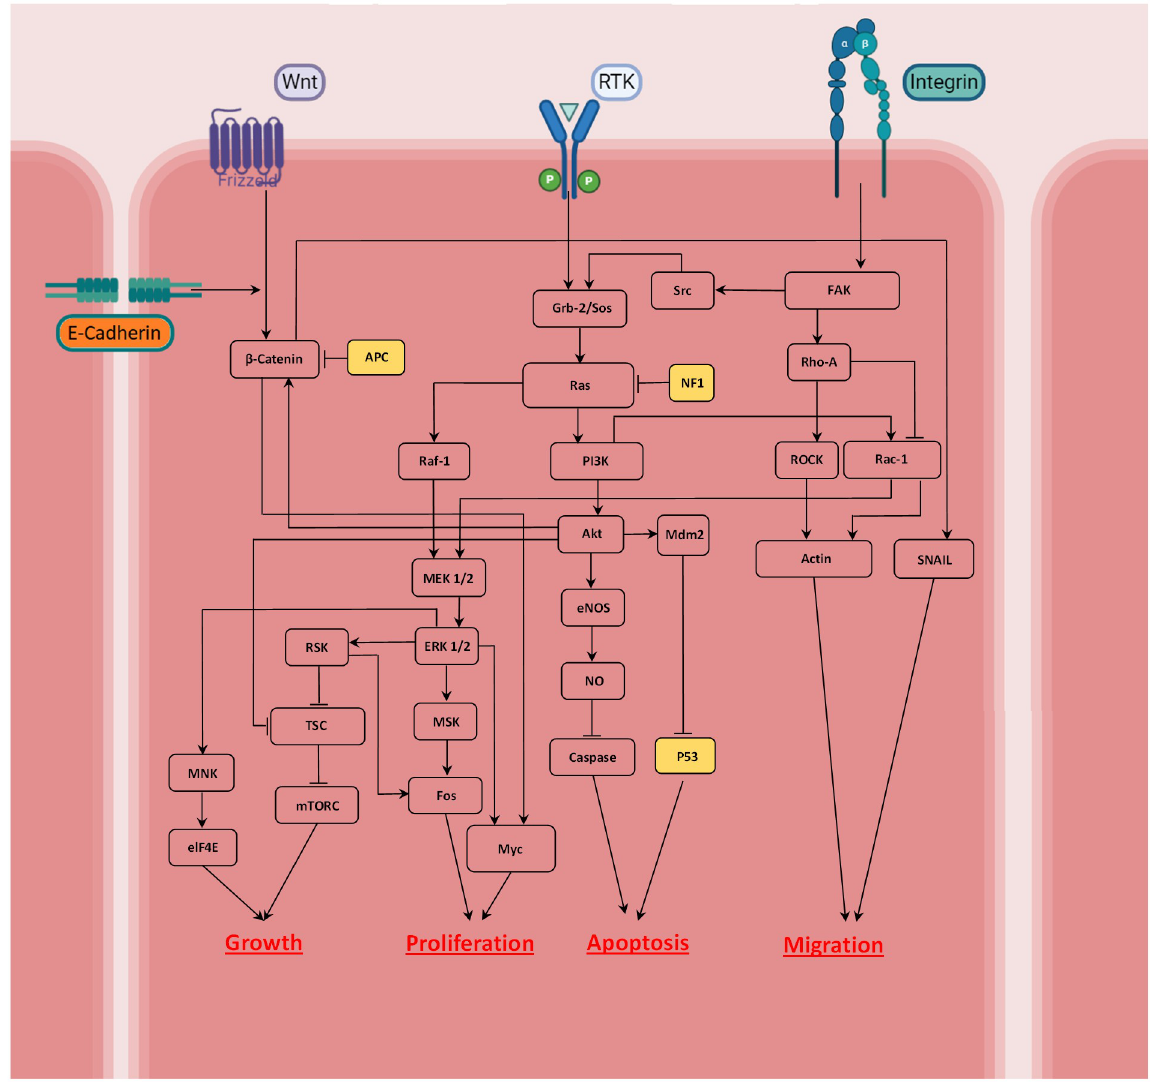
Fig 2. Signaling networks considered in the model that are involved in tumor growth; the implemented network focuses on Ras- PI3K-Akt and Wnt/ß-catenin signaling that control the cancer cell state. Highlighting the relationship between external stimuli, Wnt, RTK, cadherin and integrin, the cell can be growing, proliferating, migrating or undergoing apoptosis. A pointed head arrow indicates activation whereas a blunt head refers to